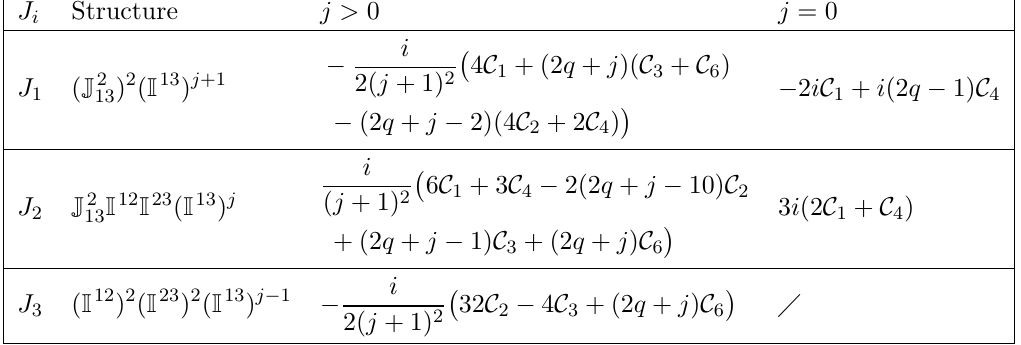
( QO ) T ( QO ) when QO h i